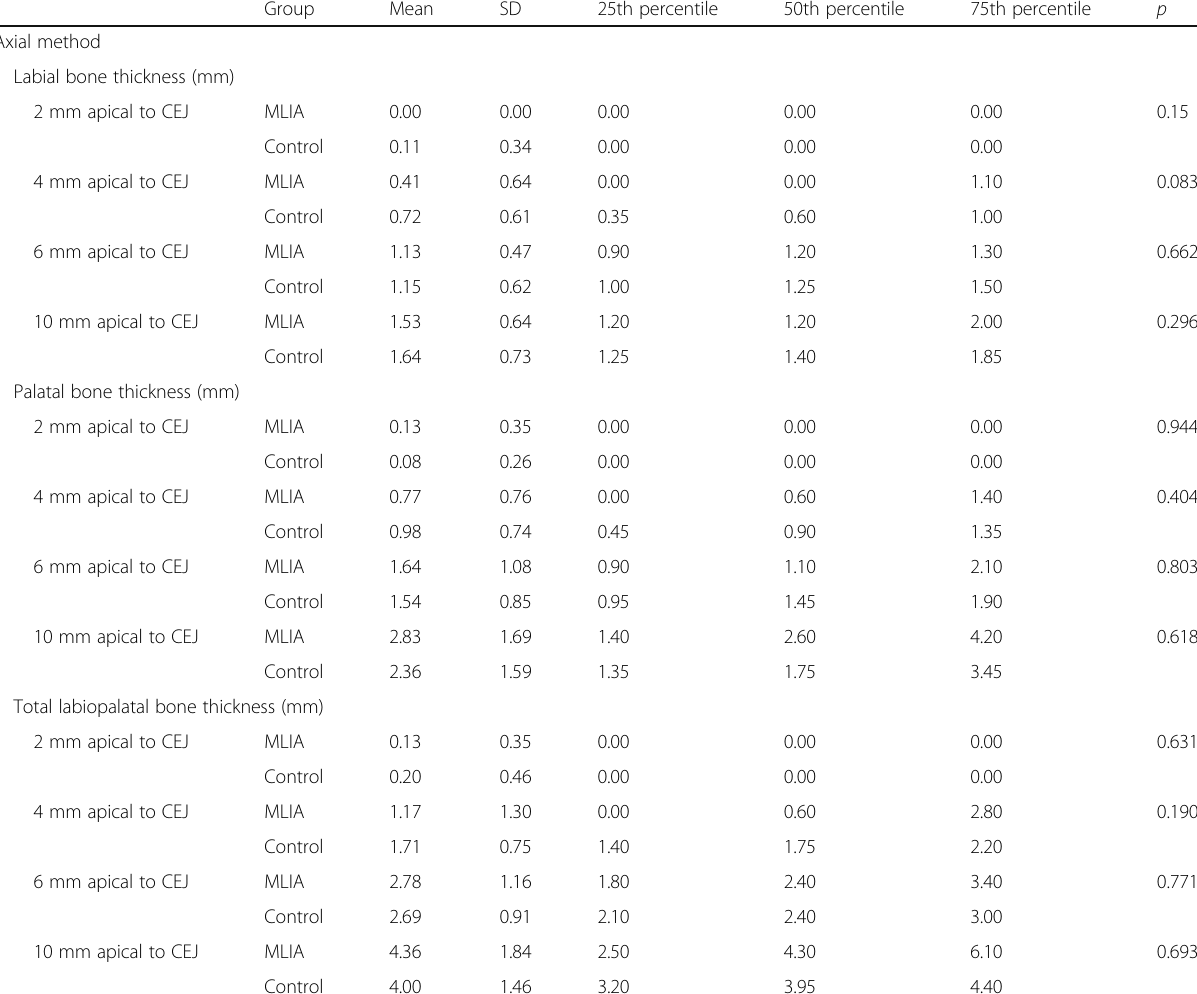
Table 5 Bone thickness parameters measured from axial sections